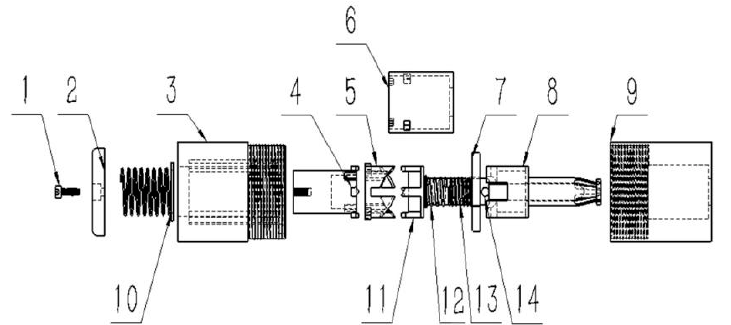
Figure 2. Exploded view of quick-press self-locking temporary fasteners. 1—Screw, 2—Round button, 3—Tail shell, 4—Cylindrical push rod, 5—Ratchet wheel, 6—Inner sleeve, 7—Baffle, 8—Clamping claw, 9—Head shell, 10—Return spring, 11—Cylindrical top rod, 12—Spring of ejector rod, 13—Supporting spring, 14—Mandrel retaining bar.